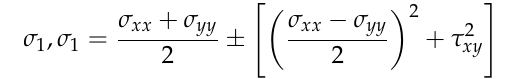
Figure 11. Definition of the coordinate axis ahead of a crack tip.